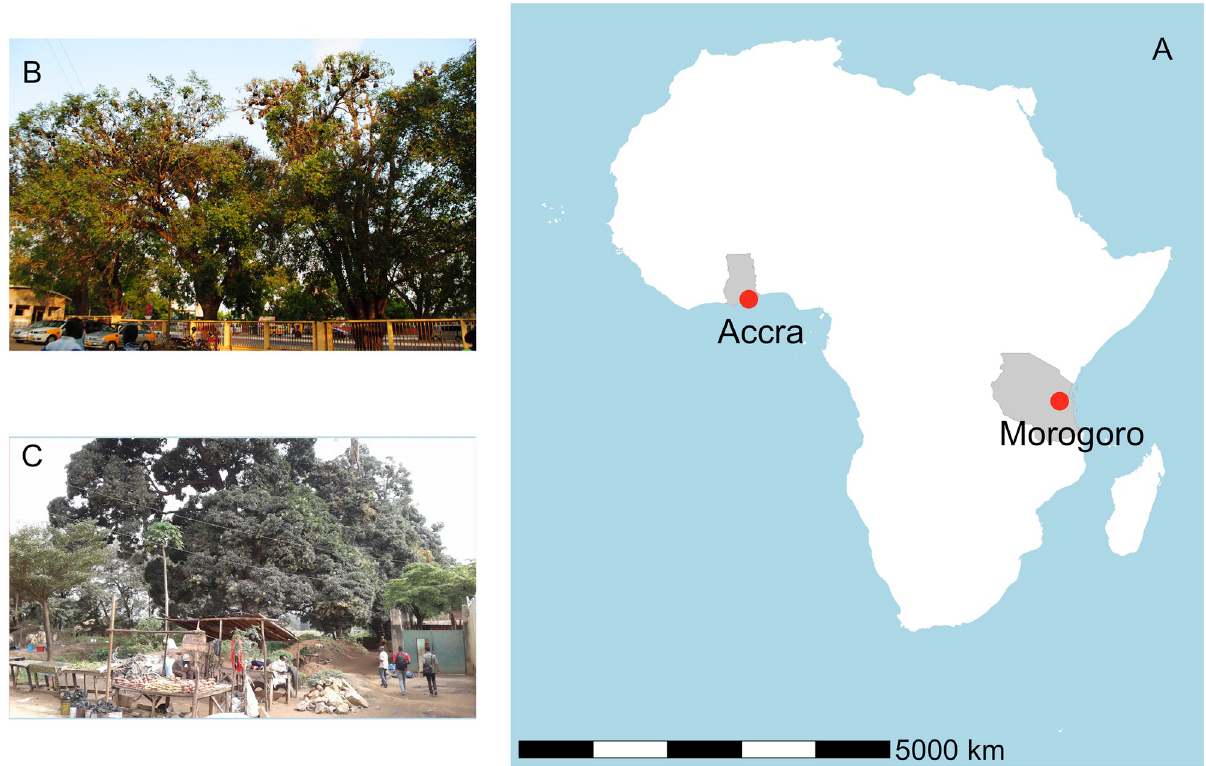
Fig 1. Location of the studied Eidolon helvum roosts. Panel A shows the locations of the roosts in Africa. Panel B shows some of the trees occupied at the 37 Military Hospital in Accra, Ghana and Panel C shows roosting bats at the Kikundi Market in Morogoro,